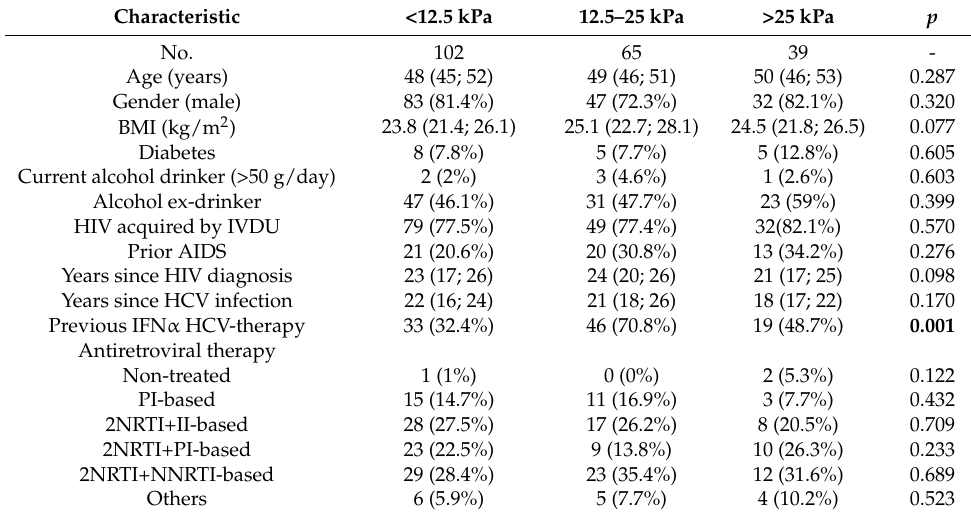
Table 1. Clinical and epidemiological characteristics of HIV/HCV-coinfected patients stratified by values of